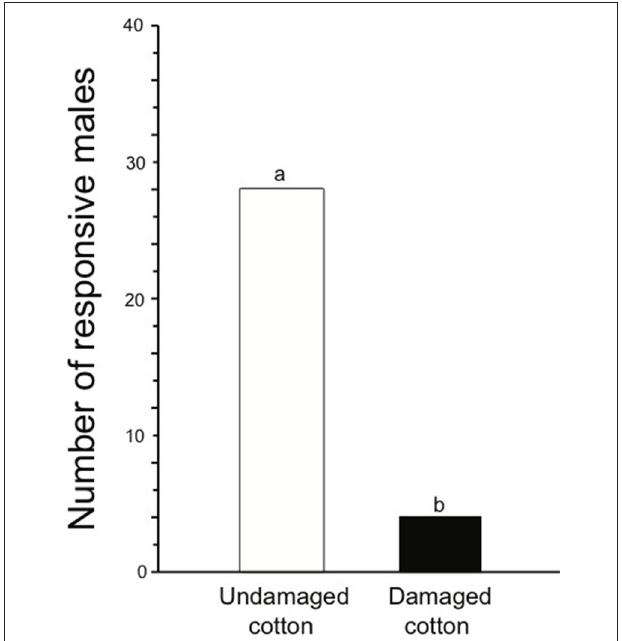
FIGURE 4 | Number of males of S. littoralis attracted toward female pheromone gland extracts in the wind tunnel having damaged (black bar) or undamaged (white bar) cotton plants as background plant volatile source in a two-choice assay. Wilcoxon signed rank test for paired differences was used for statistical analysis. Different letters are used to show significant effect ( P < 0.05, or 0.01 or